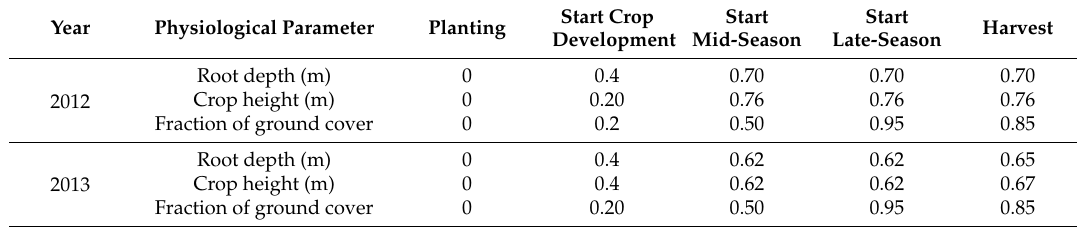
Table 3. Main crop parameters of the growth